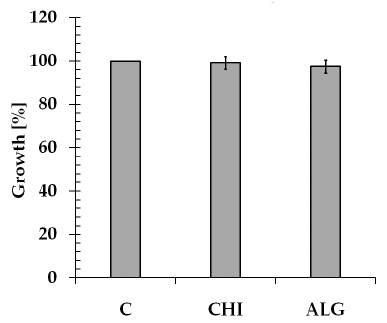
Figure 2. The 3-(4,5-dimethylthiazol-2-yl)-2,5-diphenyltetrazolium bromide (MTT) viability assay of chitosan (CHI) and sodium alginate (ALG) samples following 24 h of incubation with L929 cells. The mean ± SD values from three independent experiments (n = 3, p < 0.05).